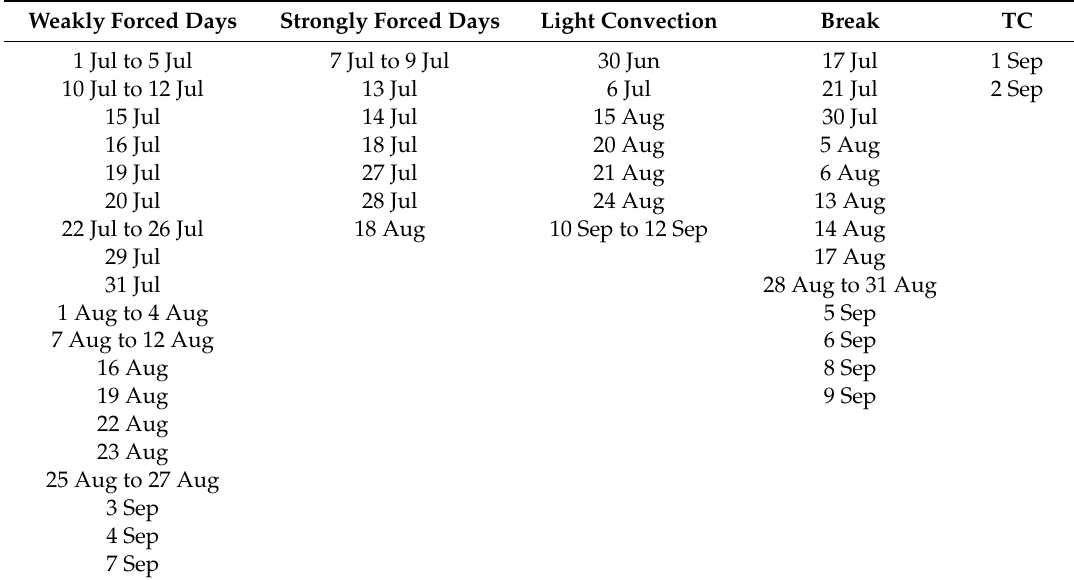
Table 6. List of days during GPS Hydromet 2017 field campaign. Based on synoptic and mesoscale features, the days are classified into strongly and weakly forced days, as well as days with light convection, tropical cyclone, and monsoon break. There are nine strongly forced days, 39 weakly forced days, nine days with light convections, 16 days of monsoon break, and 2 days of precipitation associated with the TC Lidia. Weakly Forced Days Strongly Forced Days Light Convection Break TC 1 Jul to 5 Jul 7 Jul to 9 Jul 30 Jun 17 Jul 1 Sep 10 Jul to 12 Jul 13 Jul 6 Jul 21 Jul 2 Sep 15 Jul 14 Jul 15 Aug 30 Jul 16 Jul 18 Jul 20 Aug 5 Aug 19 Jul 27 Jul 21 Aug 6 Aug 20 Jul 28 Jul 24 Aug 13 Aug 22 Jul to 26 Jul 18 Aug 10 Sep to 12 Sep 14 Aug 17 Aug 28 Aug to 31